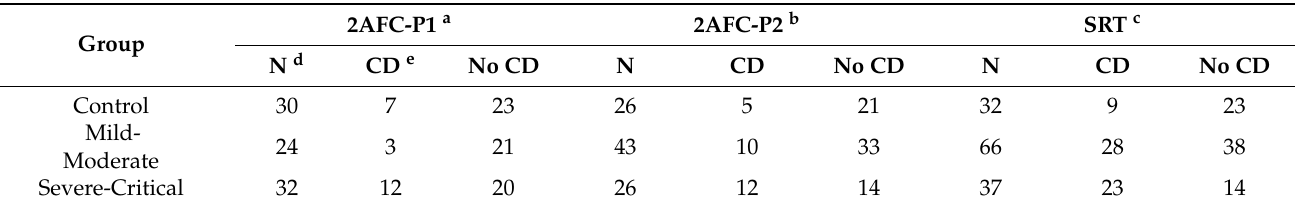
Table 2. Events for cognitive